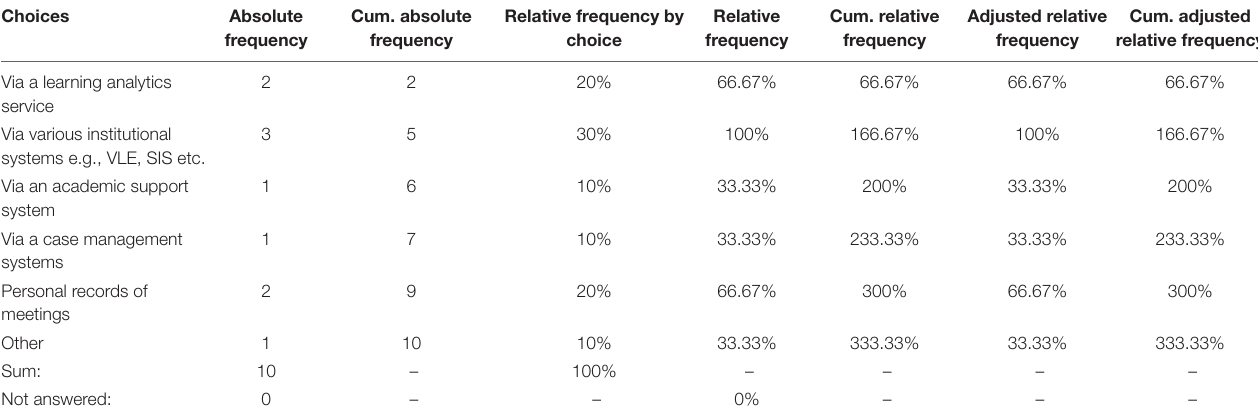
TABLE 4 | Frequency table – Q4: How is this data made available to tutors? Choices Absolute